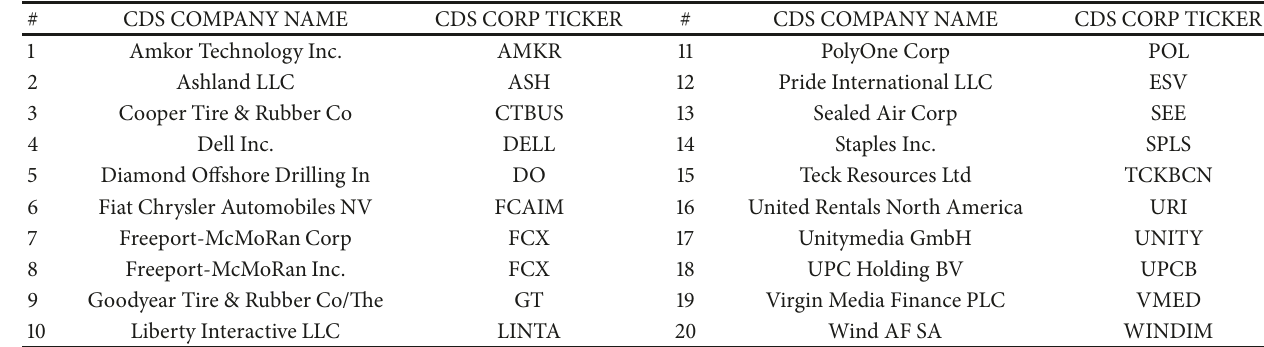
Table 10: Companies used for the HY BB-